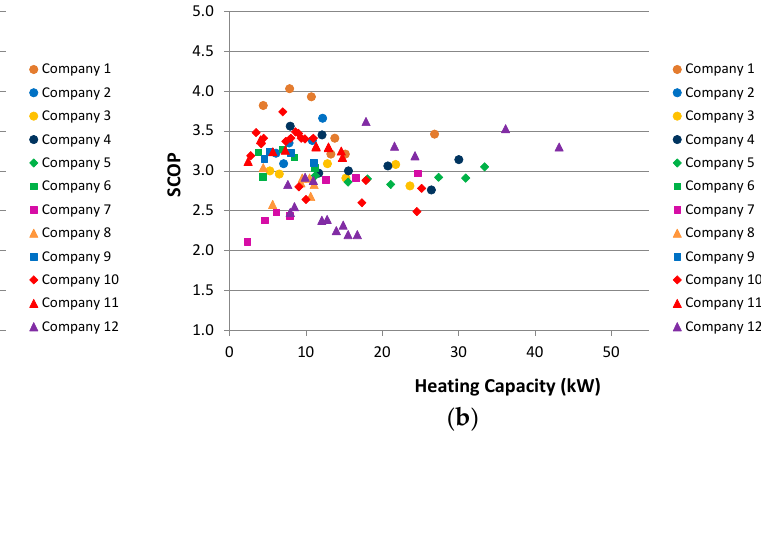
Figure 5. SCOP against HP’s heating capacity for the city of Thessaloniki: ( a ) Τ w,outlet = 35 °C—without compensation, ( b ) Τ w,outlet = 35 °C—with compensation, ( c ) Τ w,outlet = 45 °C—without compensation, ( d ) Τ w, outlet = 45 °C—with compensation, ( e ) Τ w,outlet = 55 °C—without compensation, ( f ) Τ w,outlet = 55 °C—with compensation. Finally, in the case of Florina (Climate Zone D), the SCOP values, as presented in Figure 6, range from 1.38 to 4.03. More specifically, HPs with heating capacity up to 20 kW show SCOP values that range from 2.07 to 4.03, from 1.67 to 3.51, and from 1.38 to 3.05 for Tw,outlet 35, 45 and 55 °C, respectively. The ranges of SCOP for HPs with heating capacity from 20 to 50 kW are from 2.41 to 3.53, from 1.82 to 3.03, and from 1.55 to 3.07 for Tw,outlet 35, 45, and 55 °C, respectively.